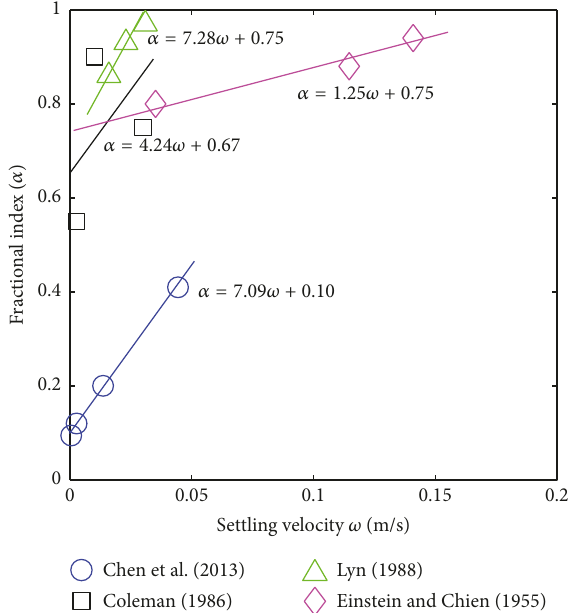
Figure 9: The relationship between the fractional index 𝛼 in the fADE model and the settling velocity 𝜔 . The best-fit functions are obtained using the least square